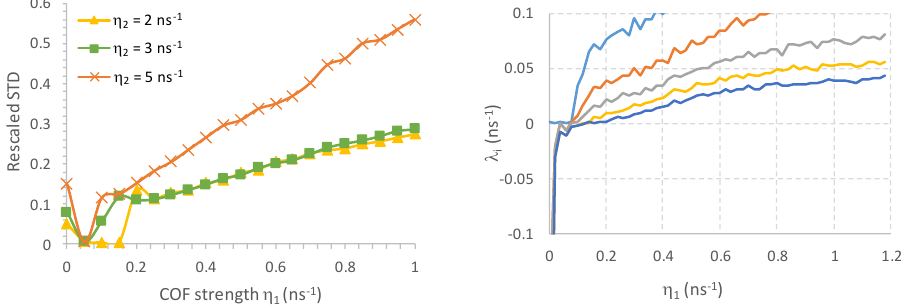
Figure 9. Standard deviation of the simulated time traces of the laser’s output as a function of the COF strength (left) and the five largest Lyapunov exponents (right) with FOF (η 2 = 3 ns –1 ) when the backscattering is set to zero.